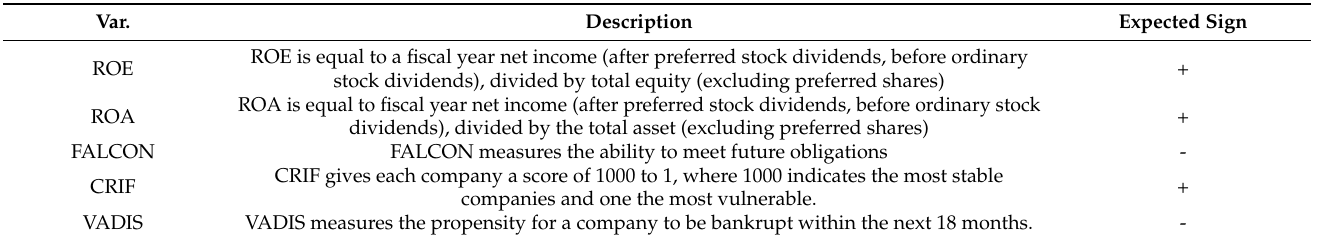
Table 1. Dependent variables